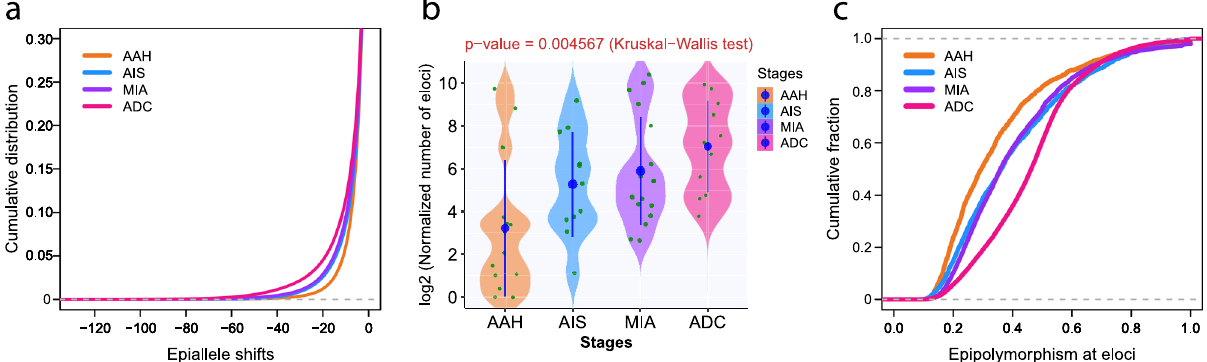
Fig. 3 Increased DNA methylation ITH in later-stage IPNs. a Cumulative distribution curves of epiallele shifts of the DNA methylome in AAH, AIS, MIA, and ADC specimens compared to normal lung, with 1st percentile of entropy as − 21.46 for AAH, − 28.88 for AIS, − 30.75 for MIA, and − 42.01 for ADC by quantile regression. b The abundance of eloci (loci with distinct epiallele shifts) among IPNs of different histologic stages. Each green dot represents the mean of normalized number of eloci in each IPN. The solid blue dots represent the mean numbers of eloci in the IPN of each histologic stage with 95% con fi dence interval as error bars. The differences among all stages were assessed using the Kruskal – Wallis H test. c The cumulative distribution curves of epipolymorphism for loci with signi fi cant epiallele shifts ( Δ S < − 60) in IPN specimens of AAH, AIS, MIA, and ADC, with 50th percentile of epipolymorphism as 0.295 for AAH, 0.362 for AIS, 0.359 for MIA, and 0.463 for ADC by quantile regression. X -axis denotes the epipolymorphism in IPN specimens at each loci. Y -axis denotes the cumulative fraction of epipolymorphism from all IPN specimens of each stage. Source data is provided as a source data fi